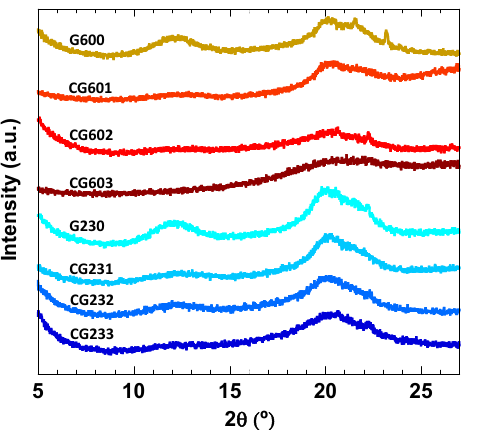
Figure 7. XRD spectra of the 2 wt% cellulose solutions with different concentrations of MBA and curing conditions (see table one for details).